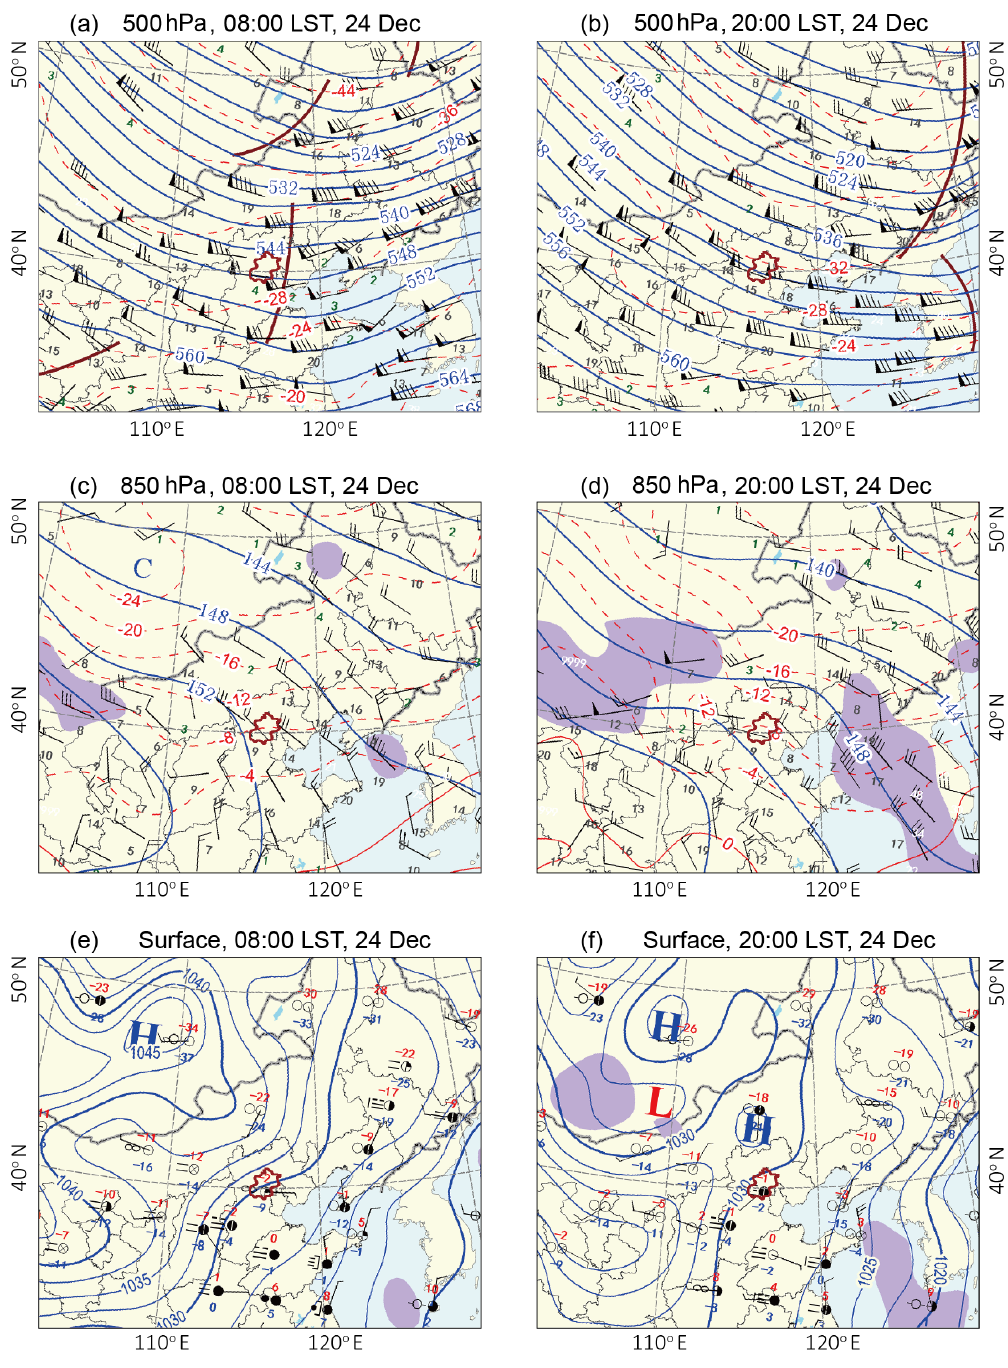
Figure 3. The 500hPa weather maps at (a) 08:00LST and (b) 20:00LST, the 800hPa weather maps at (c) 08:00LST and (d) 20:00LST, and surface maps at (e) 08:00LST and (f) 20:00LST on 24 December 2015. The administrative boundaries of Beijing are marked in